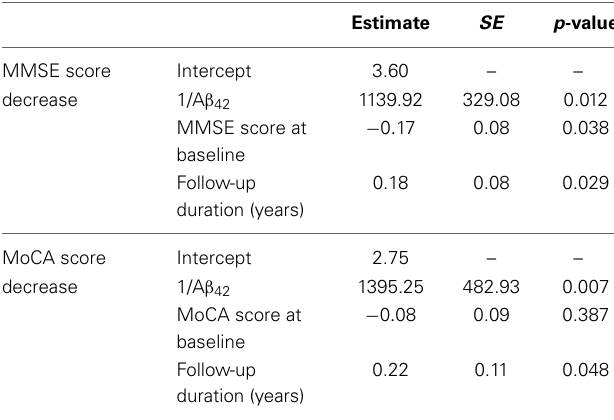
Table 6 | Linear regression analyses of cognitive decline in PD